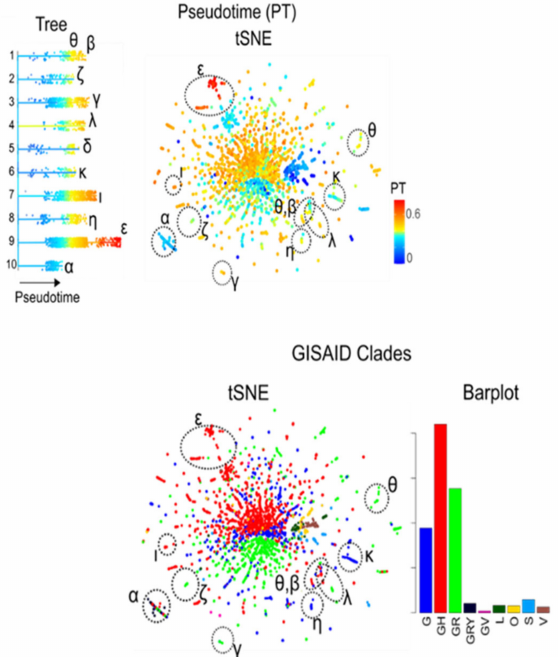
Figure A9. The URD-tree is colored in pseudotime (PT) scale. Most branches cover PT-ranges up to PT = 0.5–0.6. Shortest PT range is obtained for VOI alpha and the longest for VOI epsilon. The PT range seems to be governed by the number of intermediate virus genomes in between the initial and final states. t-SNE (t-distributed neighbor embedding) plots of the variants in PT and GISAID color scale reveal that clade GH (including VOI epsilon) covers the widest PT range.